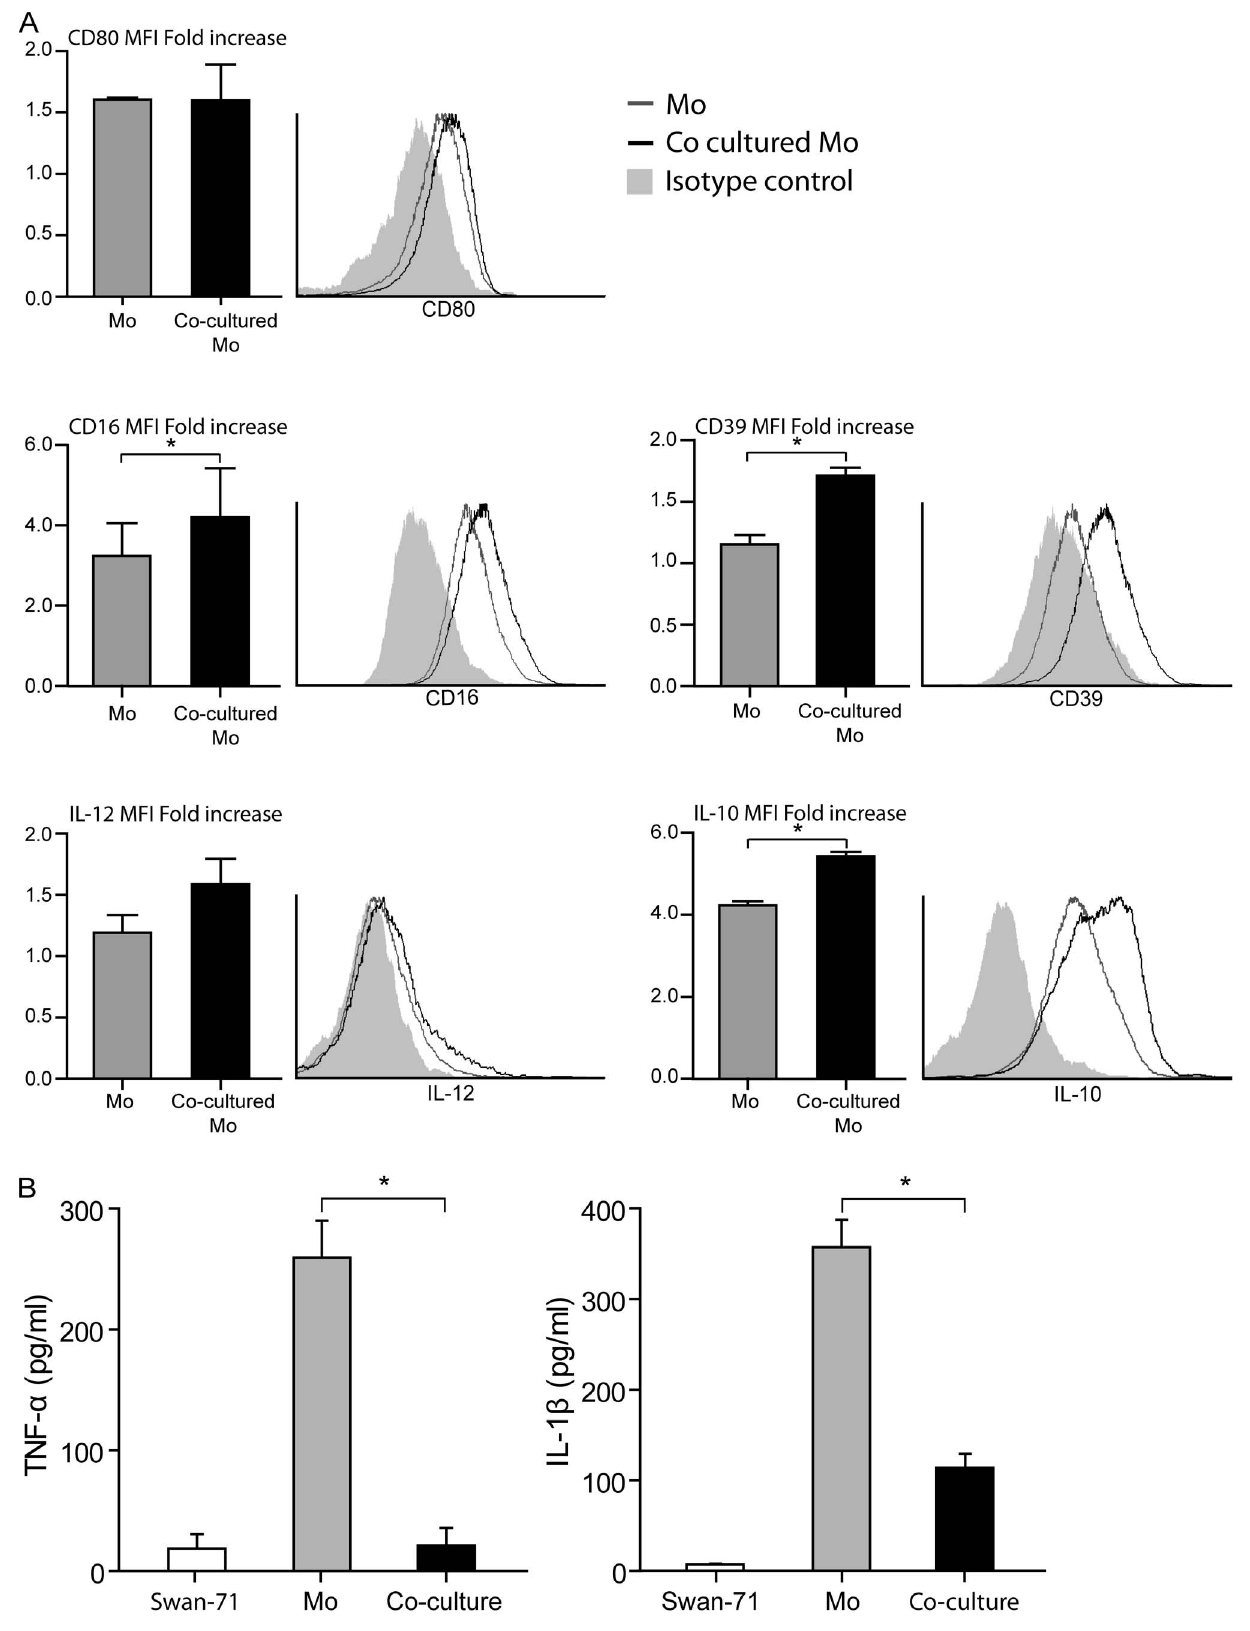
Figure 1. Trophoblast cells induce and alternative profile on maternal CD14 + cells. Maternal monocytes purified by magnetic beads were cultured or not with Swan-71 cells at 70% of confluence in a 24 well flat-bottom plate. After 24 hours of culture, cells were recovered by TrypLE